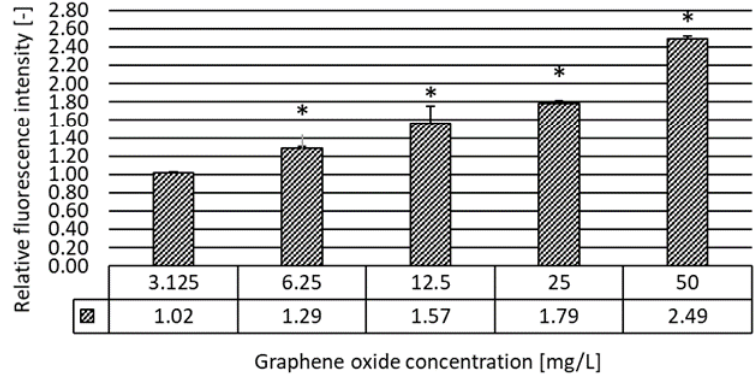
Figure 8. The effect of graphene oxide on ROS production in D. magna after 48 h of exposure in relative fluorescence intensity units when compared to the untreated control. Significant effect compared to the control is marked by an asterisk (*).